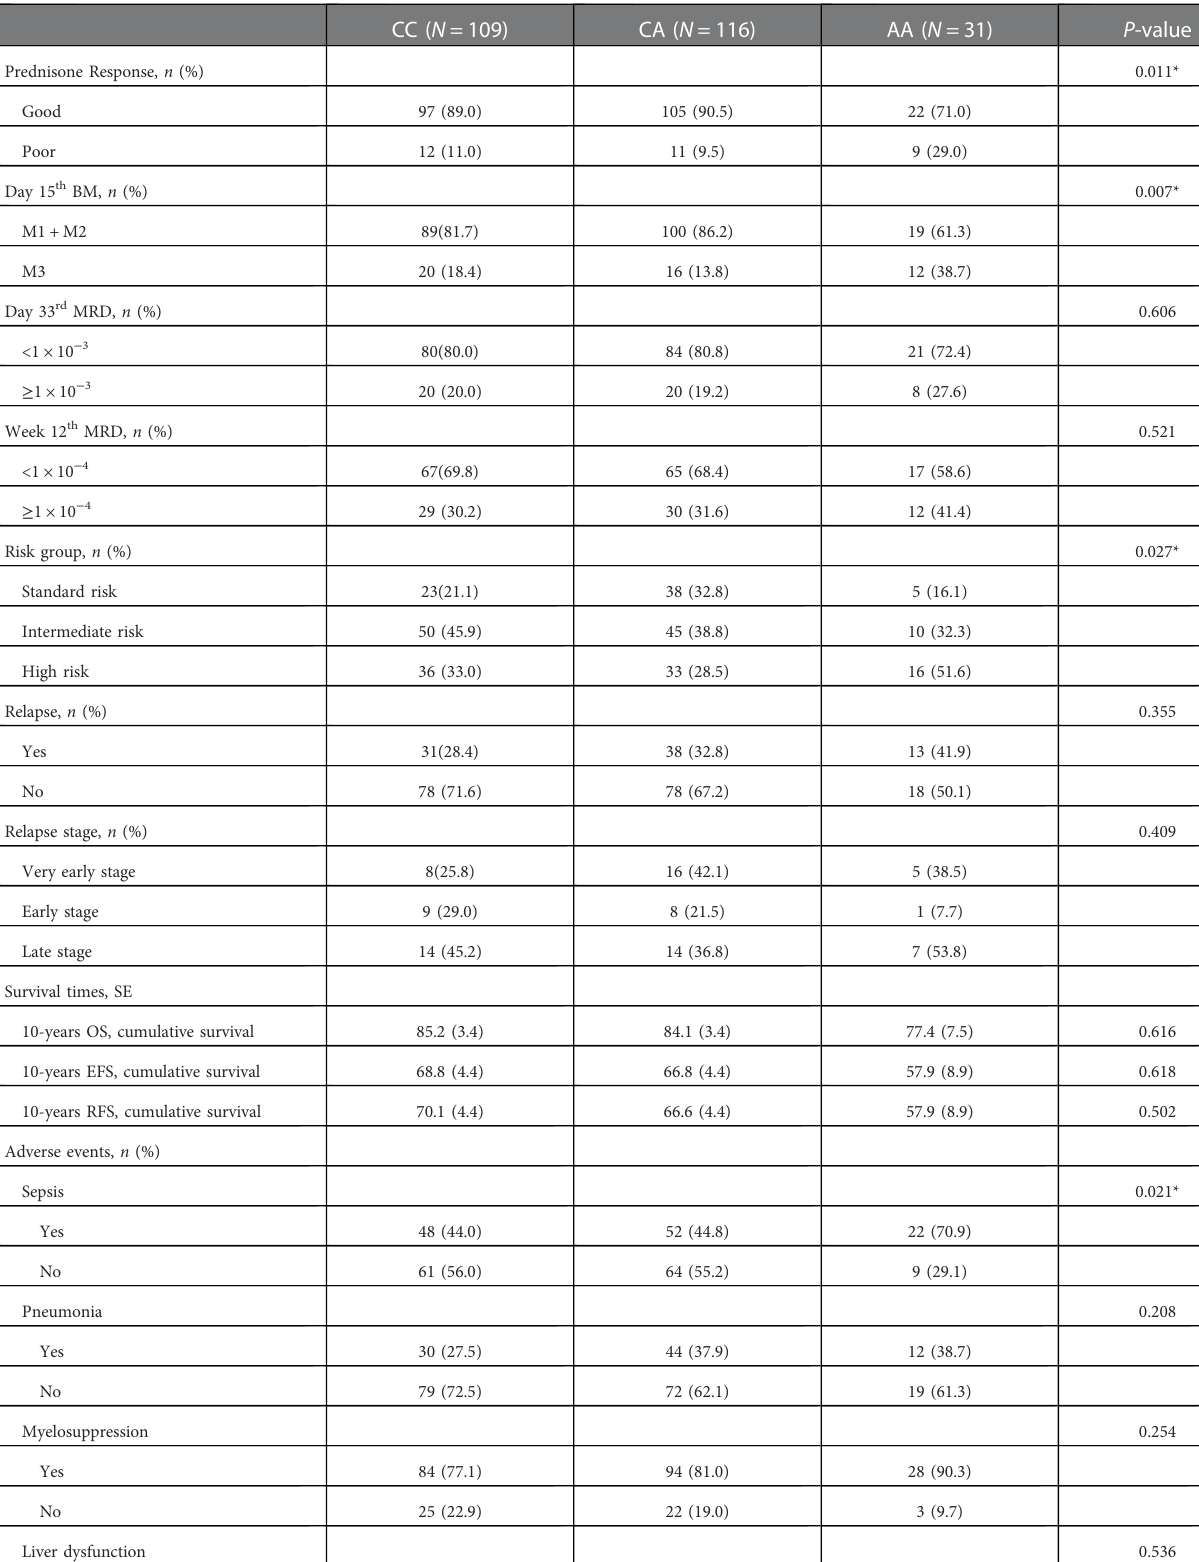
TABLE 3 The effect of GATA3 genotypes on the treatment response and outcome in pediatric